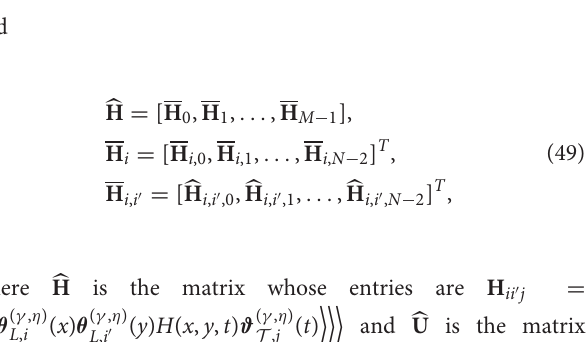
Frontiers in Physics |